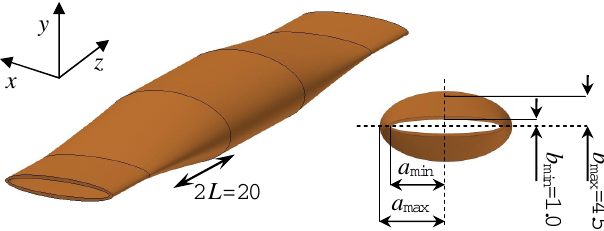
FIG. 1. (Color) Geometry with principal dimensions in